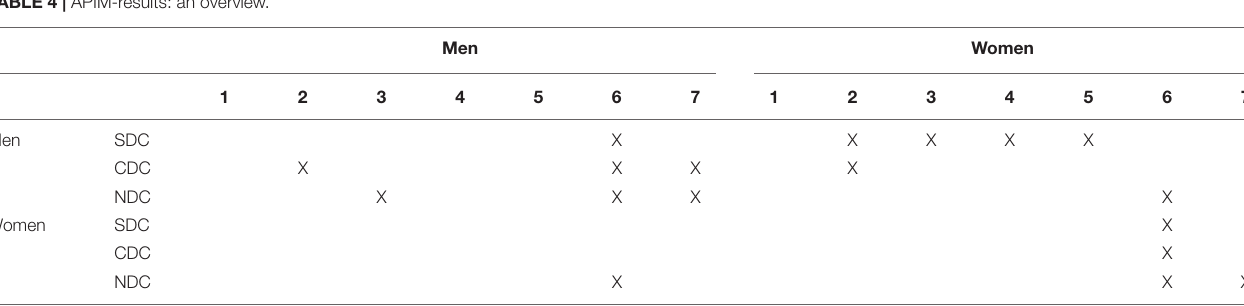
TABLE 4 | APIM-results: an